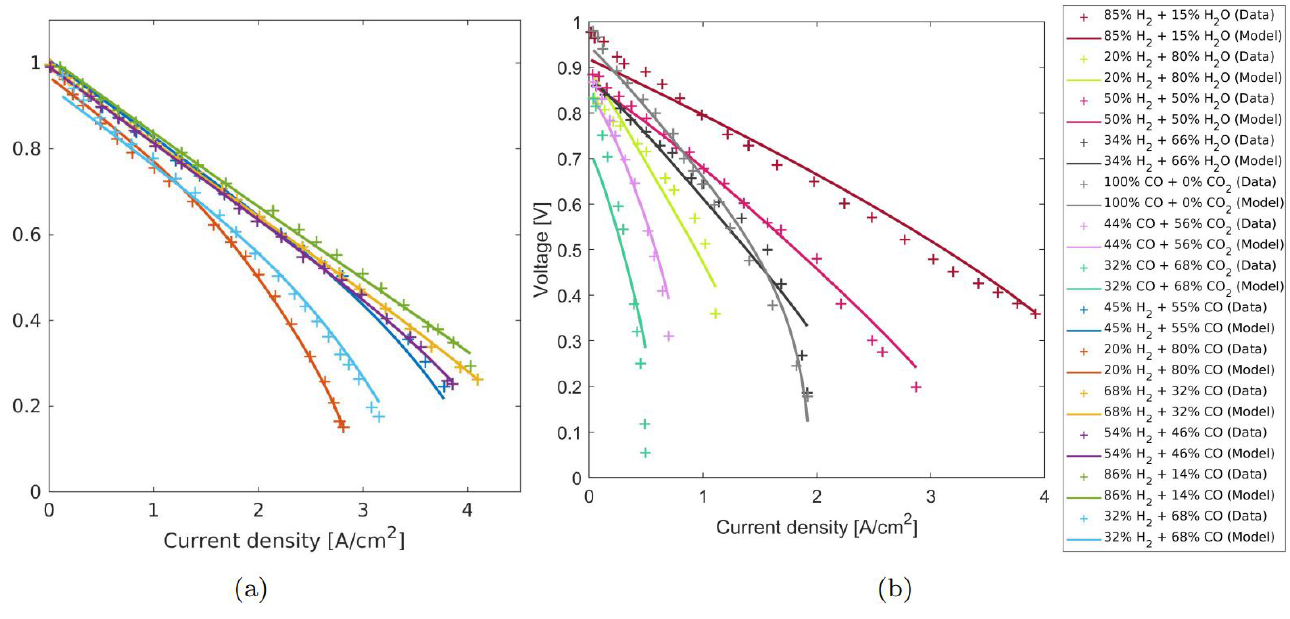
Figure 5. The first test in the scope of extrapolation validation; the results of the calibrated model on ( a ) the training data set consisting of the first six polarisation curves and ( b ) the validation data set consisting of the last seven polarisation